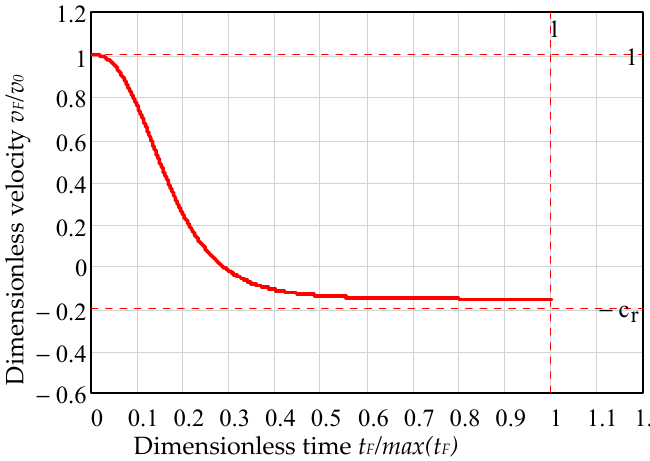
Figure 2. Dimensionless velocity versus dimensionless time.